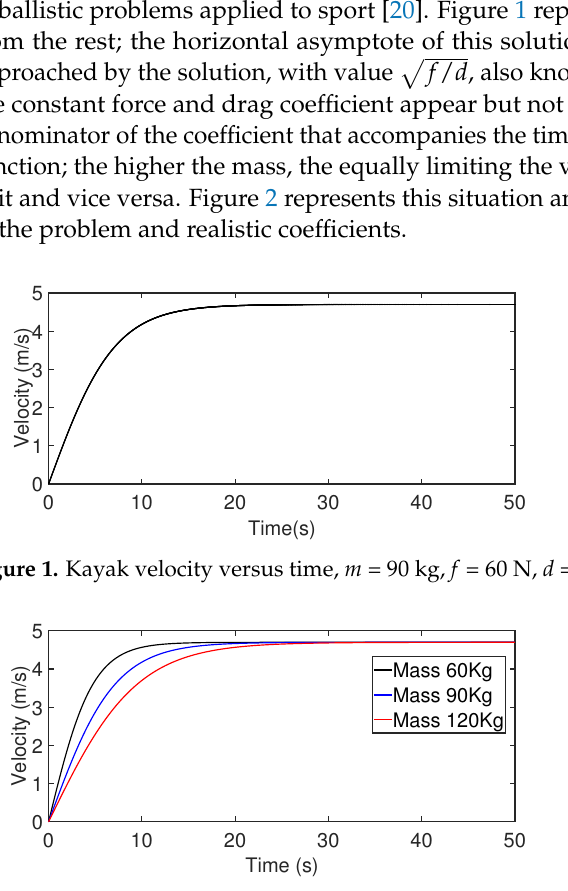
Figure 2. Kayak velocity versus time for three masses (see legend); f = 60 N, d = 2.72